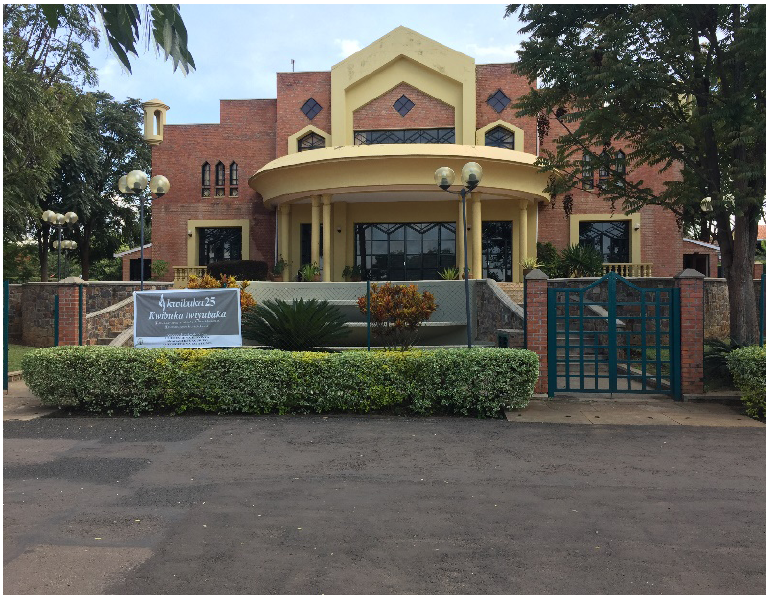
Figure 29. The Kigali 2020 Church. Photograph by Manlio Michieletto.